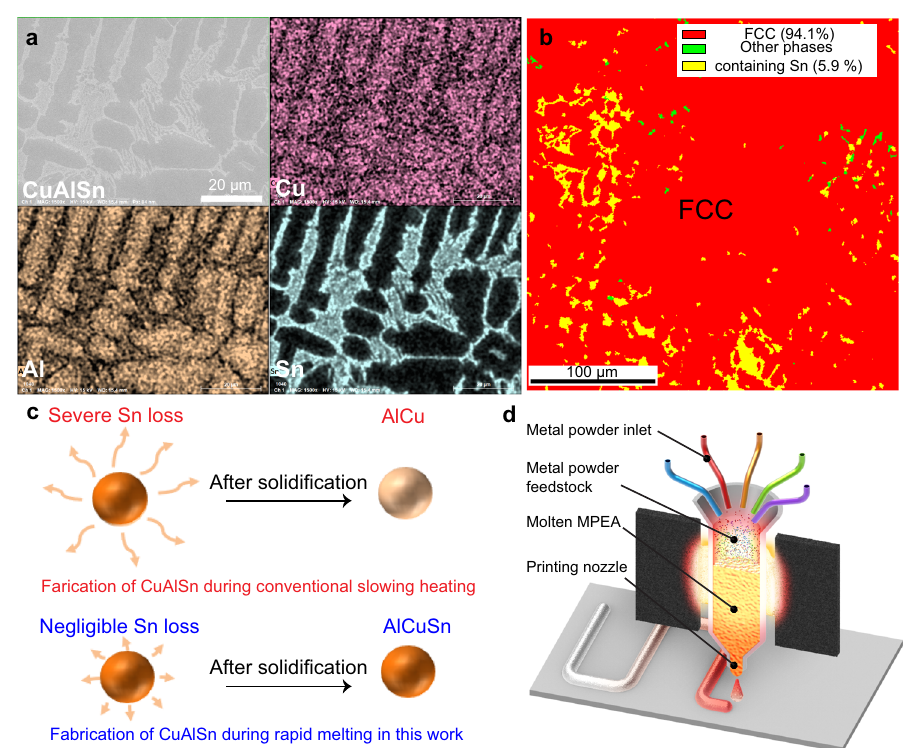
Fig.4|Demonstrationoftheminimizedlossofvolatileelementsandschematic ofthe ultrahigh-temperaturerapid meltprintingplatform asaheating source for practical3D metalprinting.a SEM and EDS ofthe CuAlSnfabricatedby rapid melt printing. b EBSD of CuAlSn, showing a major FCC phase (~94.1 vol.%) and a small fraction of minor phases containing Sn (~5.9 vol.%). c Schematics of the